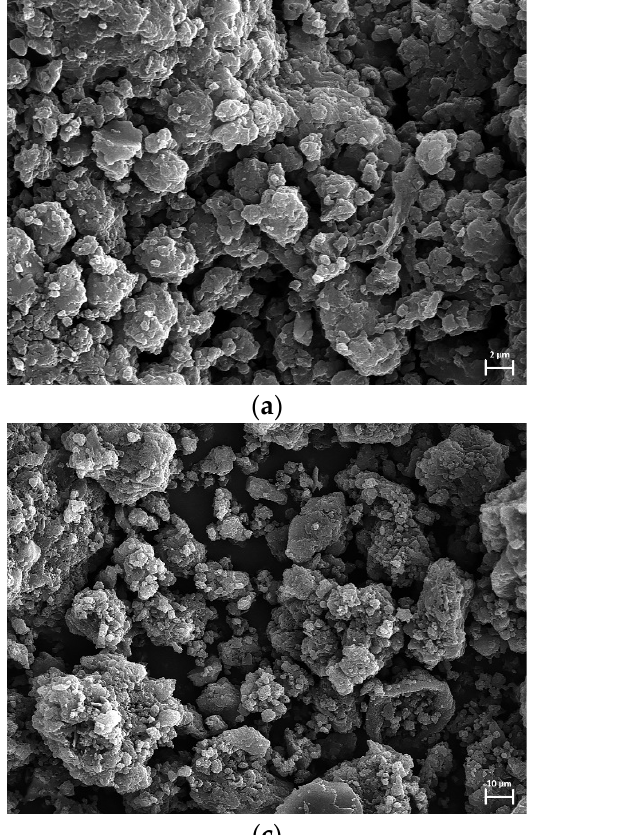
Table 3. Acid-base properties of the biocarbons obtained. Biocarbons